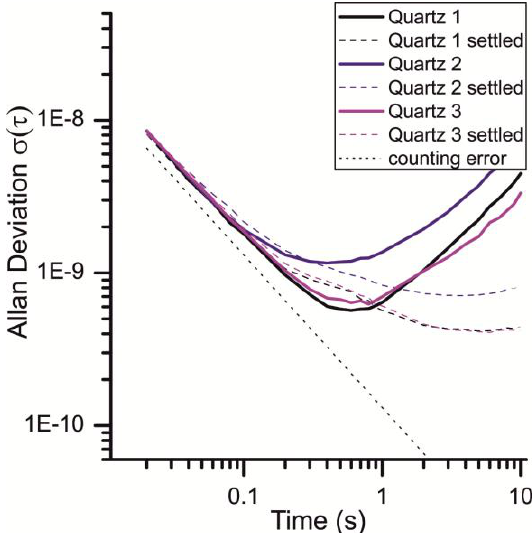
Figure 7. Allan deviation under atmospheric pressure at the beginning of a measurement and after 8 h operation